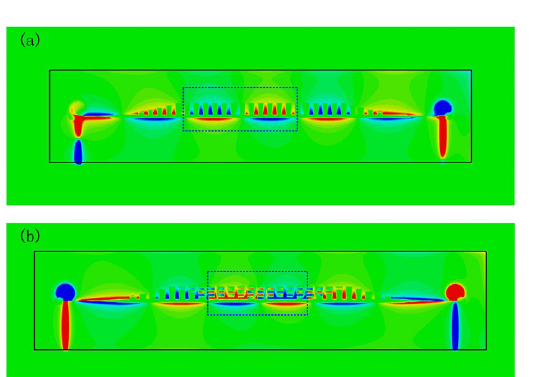
Figure 4. Two-dimensional distribution of electric field of ( a ) the traditional corrugated CSSPP waveguide and ( b ) the proposed design with IS-loaded. Areas within one phase period are labeled by blue dotted wire frame to illustrate the equivalent operating